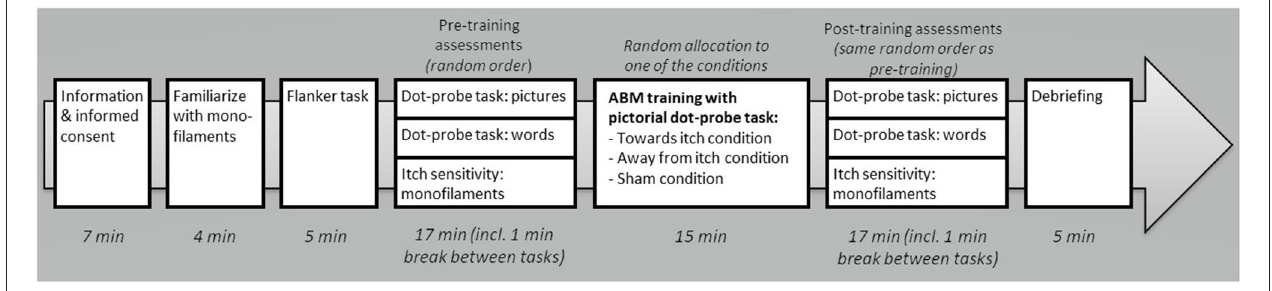
FIGURE 1 | Timeline of the experimental session (total ca. 1 h:10